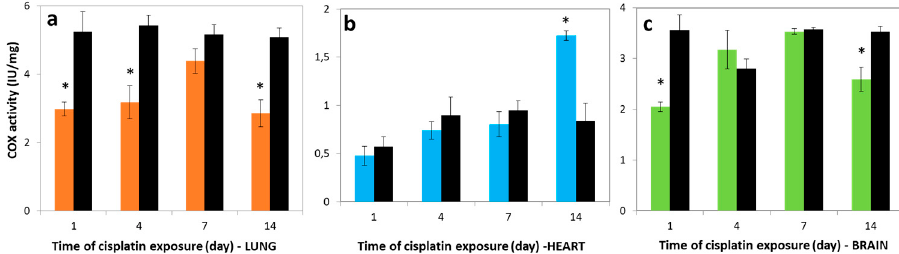
Figure 2. Cytochrome c oxidase (COX) activity in ( a ) lung, ( b ) heart, and ( c ) brain tissues over time. Lung (— (cid:4) —), heart (— (cid:4) —), and brain (— (cid:4) —) treatment groups, and controls (— (cid:4) —). Results are expressed as mean ± SD ( n = 6). * Significantly different ( p < 0.05) from control.